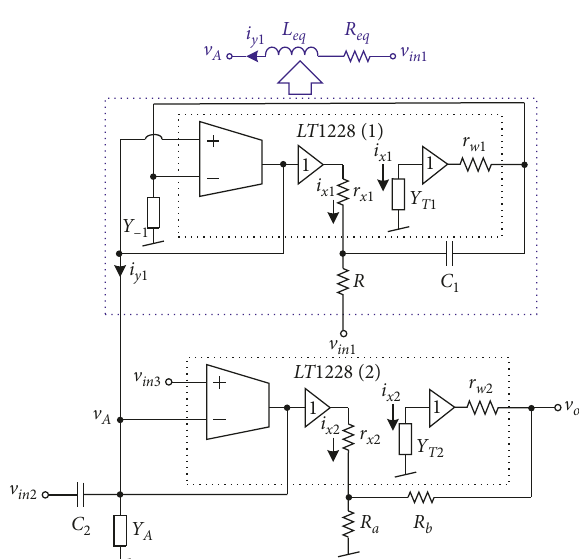
Figure 5: Proposed multifunction active filter with parasitic